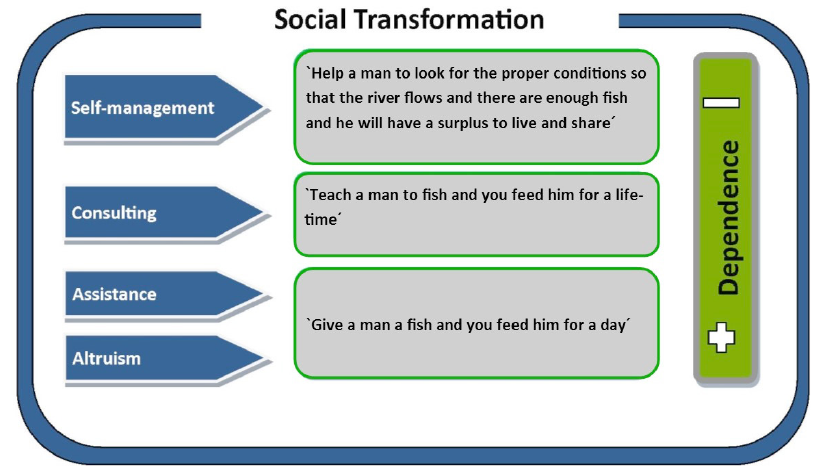
Figure 2. University Social Action Model (MASU).